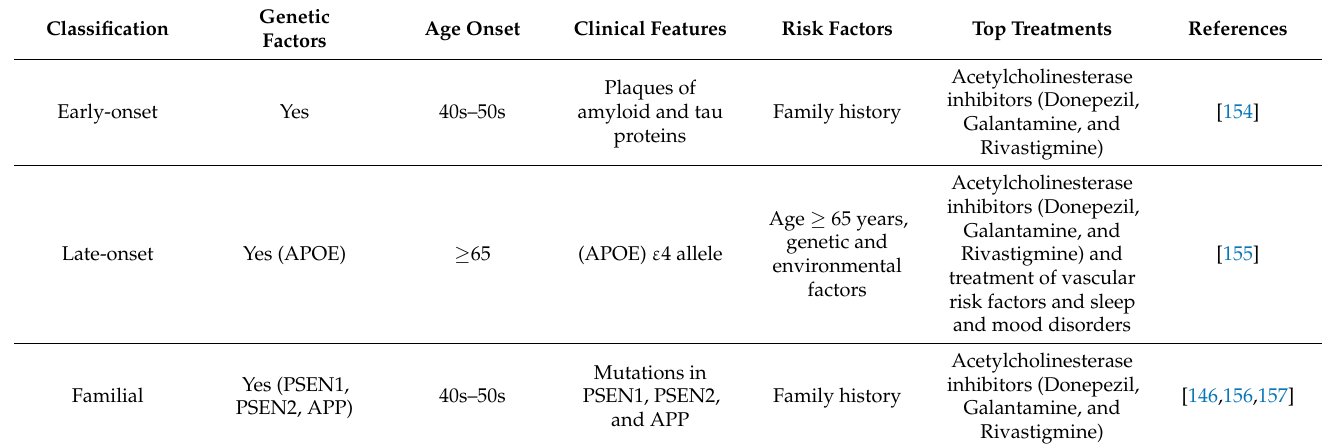
Table 1. Main types of Alzheimer’s disease based on age and